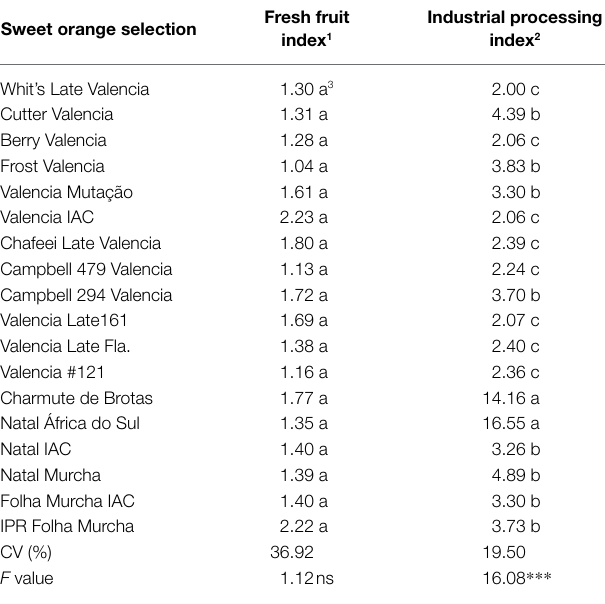
TABLE 7 | Fresh fruit and industrial processing indices of 18 late-season sweet orange selections grafted onto Rangpur lime rootstock under humid subtropical conditions in Guairaçá, state of Paraná, Brazil, from 2016 to 2021 cropping season average. Sweet orange